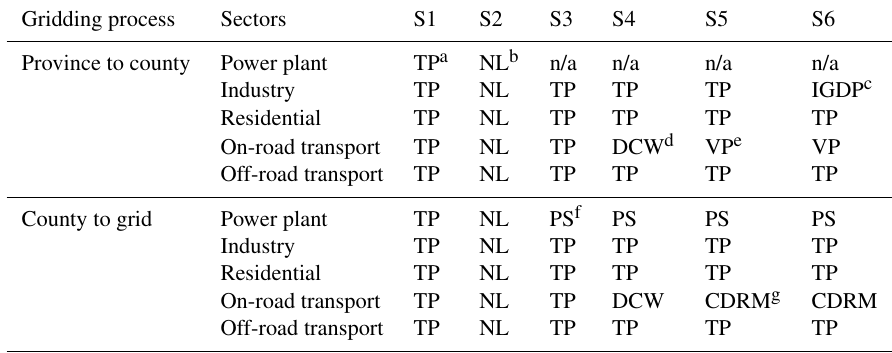
Table 3. Spatial proxies used in the gridding process for the six emission scenarios developed in this study. Gridding process